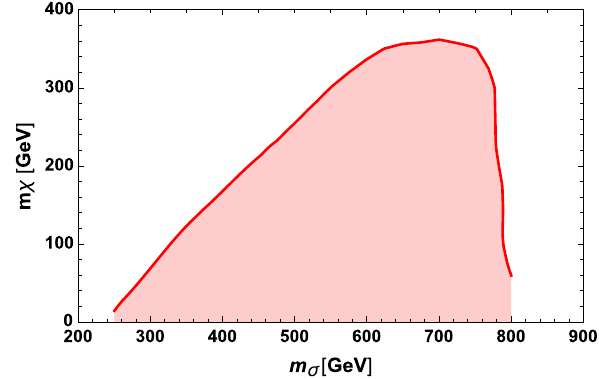
Fig. 1 The red region under the curve corresponds to the excluded region at 95% confidence level by the reinterpretation of the results of the CMS-SUS-17-001 search for stops, assuming BR t χ = 100%. Our findings are represented in the ( m σ , m χ ) mass plane